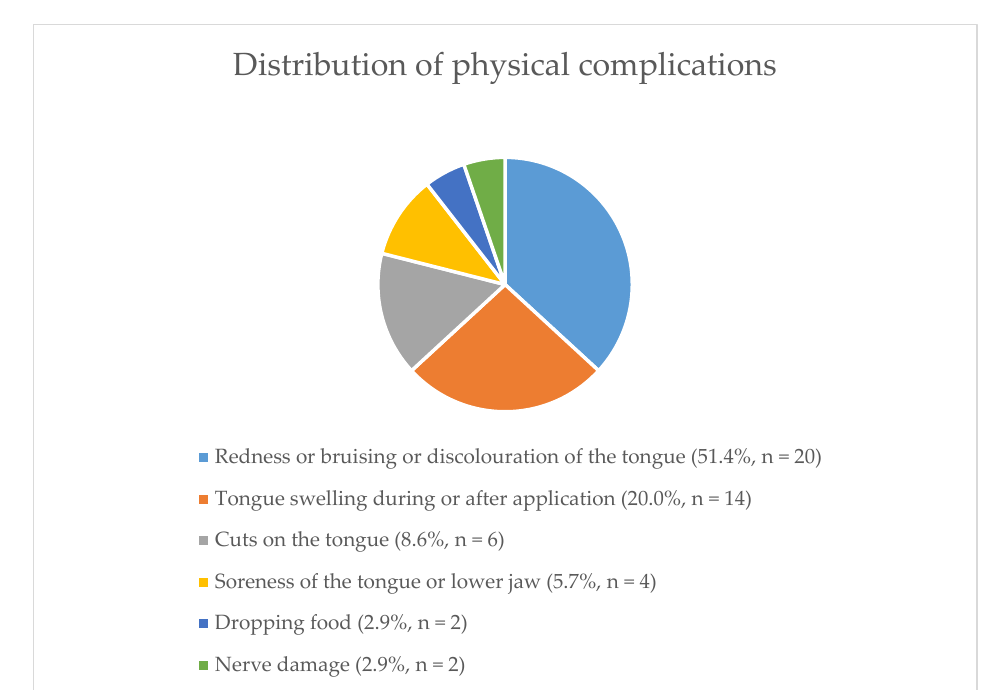
Figure 1. The distribution of physical complications reported by respondents ( n = 36). Out of 70 respondents, 37 reported one or more complications due to TT use. More physical complications were reported by TBTs (53.2%, n = 25) than SB respondents (21.7%, n = 5) [Odds Ratio (OR) = 15.6; 95% CI = 3.0–156.9]. Checking TT tightness by noting the tongue as not moving was associated with increased reporting of having observed physical complications (OR= 6.59; CI 1.1–67.5). Other risk factors for physical complications did not reach statistical significance.